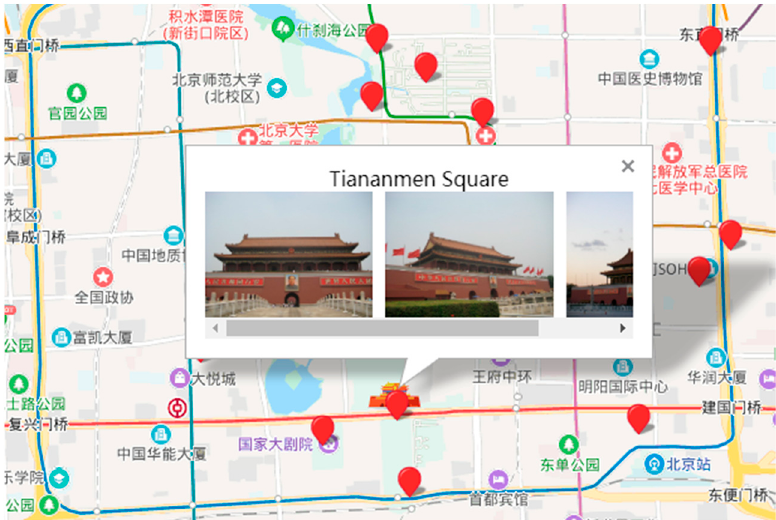
Figure 13. The screenshot of the tourist map. Table 4. Rating results of Q1, Q2, and Q3 in the